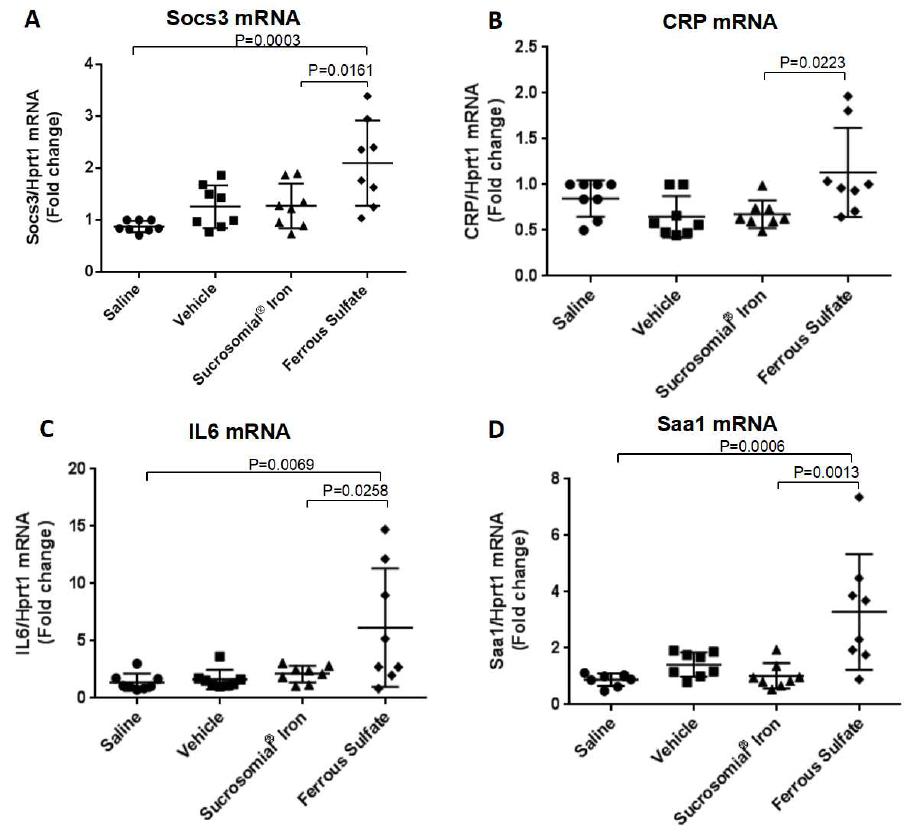
Figure 5. Effects of oral iron supplementation on the inflammatory markers Socs3 CRP, IL6 and Saa1 mRNAs. ( A ) qPCR for Socs3, ( B ) CRP, ( C ) IL6 and ( D ) Saa1 normalized for Hprt1 were performed on samples derived from liver of mice treated with Saline, Vehicle, Sucrosomial ® Iron and Ferrous Sulfate (1 mg/kg) by gavage for two weeks. In ( A ), ( B ), ( C ) and ( D ) Saline (circles), Vehicle (squares), Sucrosomial ® Iron (triangles), Ferrous Sulfate (diamonds) and iron balance group (inverted triangles). p values were obtained by one-way ANOVA.